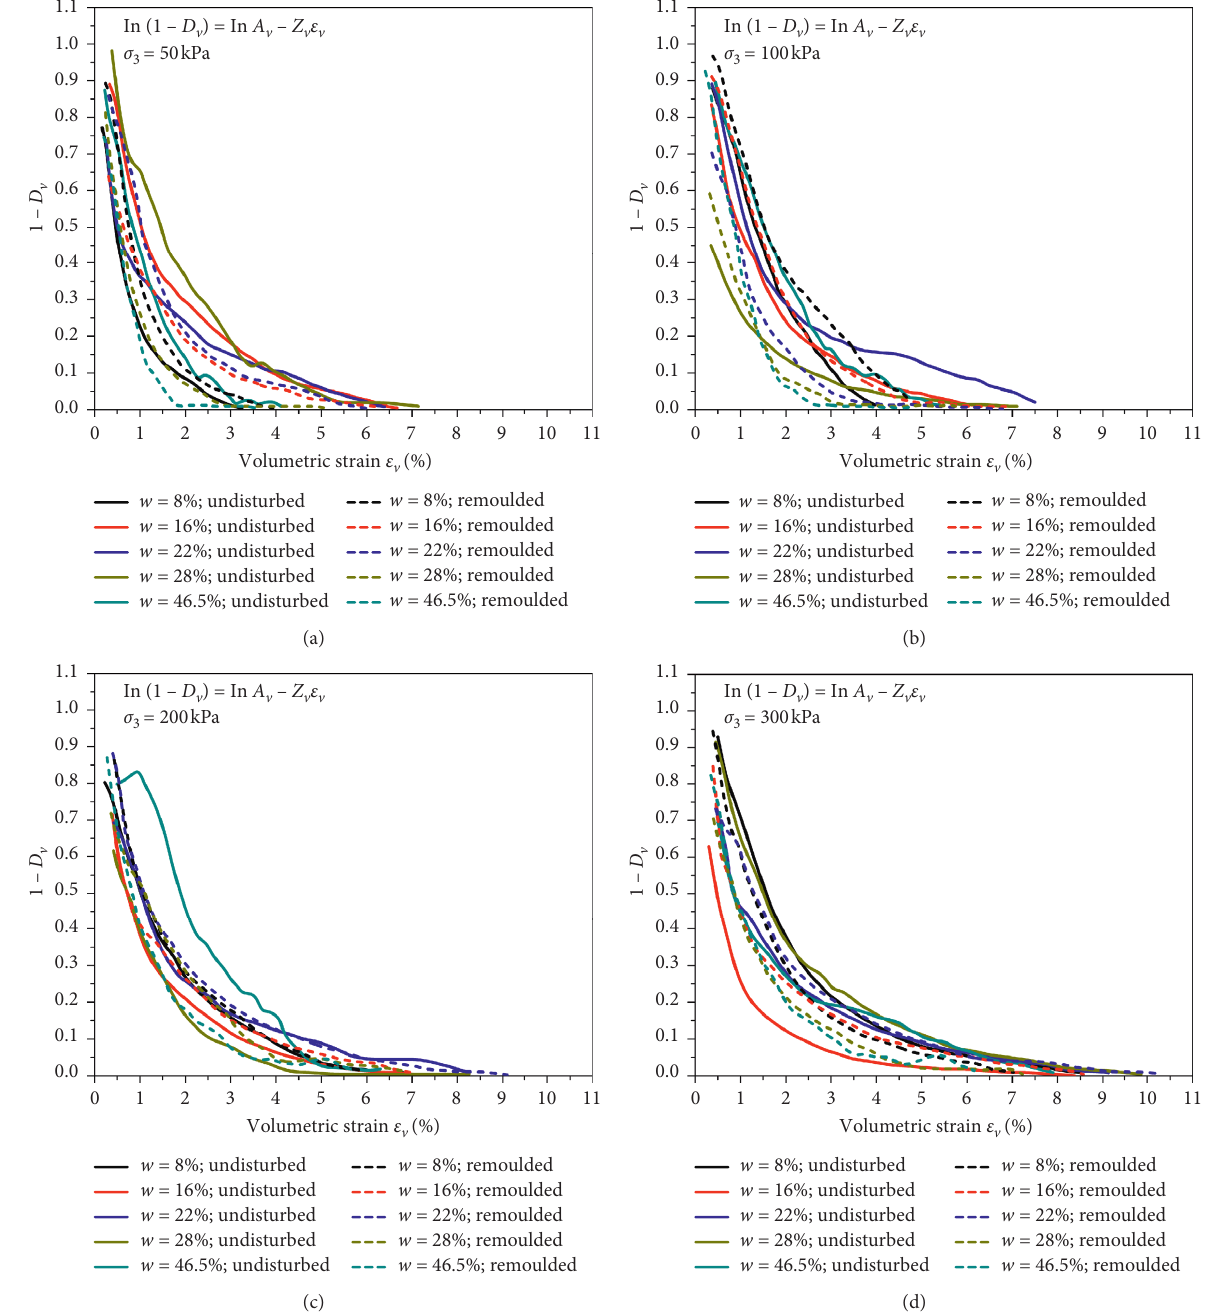
Figure 6: Evolution curves of disturbance functions based on volumetric strain for undisturbed and remoulded soil samples. (a) σ (b) σ 3 � 100kPa; (c) σ 3 � 200kPa; (d) σ 3 �